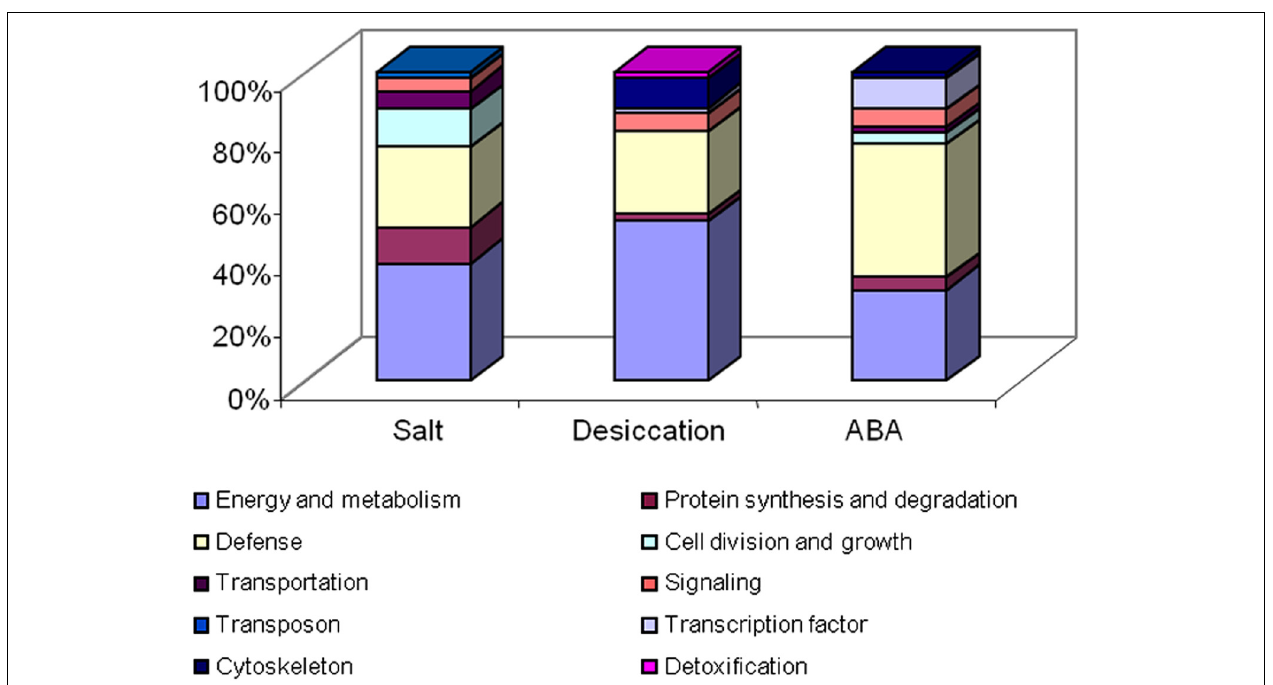
FIGURE 2 | Functional categorization of the differential displayed proteins under the treatment of salt, desiccation, andABA. This figure was based on our previous data (Wang etal., 2008, 2009a,b,